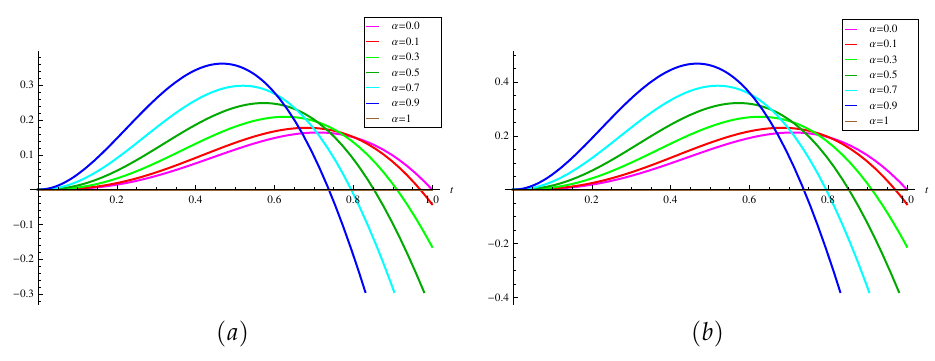
Figure 5. The Caputo gH-derivatives ( a ) y ( t ) and ( b ) y ( t ) in r = 0.5 of solution defined in Example 4 for different values of α .